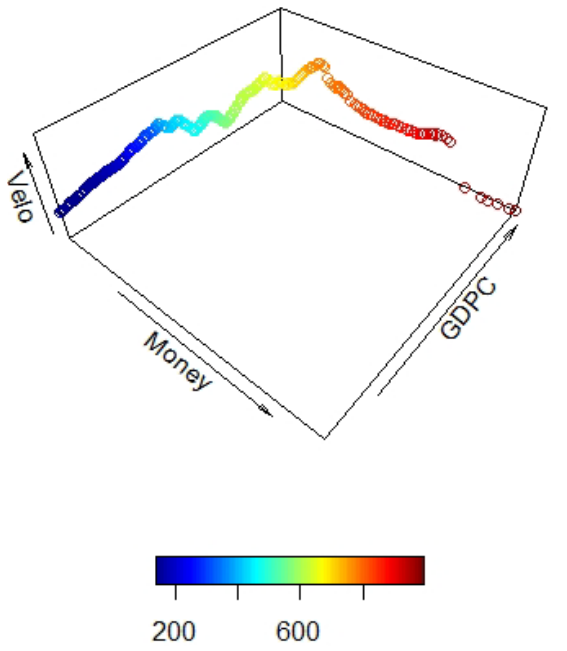
Figure 2. Inflation as a function of money stock and velocity, excluding GDP.